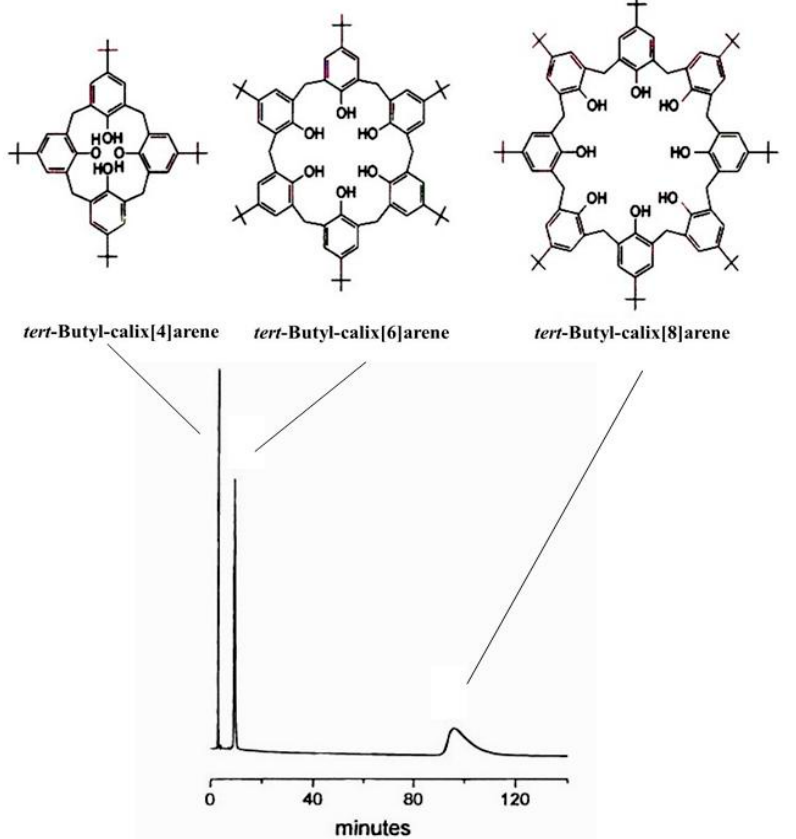
Figure 30. Top : Structures of tert -butyl-calix[ n ]arenes. Bottom : HPLC trace for the separation of tert -butylcalix[ n ]arenes on a 6,6-[60]fulleropyrrolidine stationary phase (Figure 24). 250 × 1.8 mm I.D. stainless steel column. Eluent: CH 2 Cl 2 /2-propanol (99.5/0.5), flow rate 0.3 mL/min; T: 25 °C; UV detection at 280 nm. Reprinted with permission from [105]. Copyright (1997) American Chemical Society.